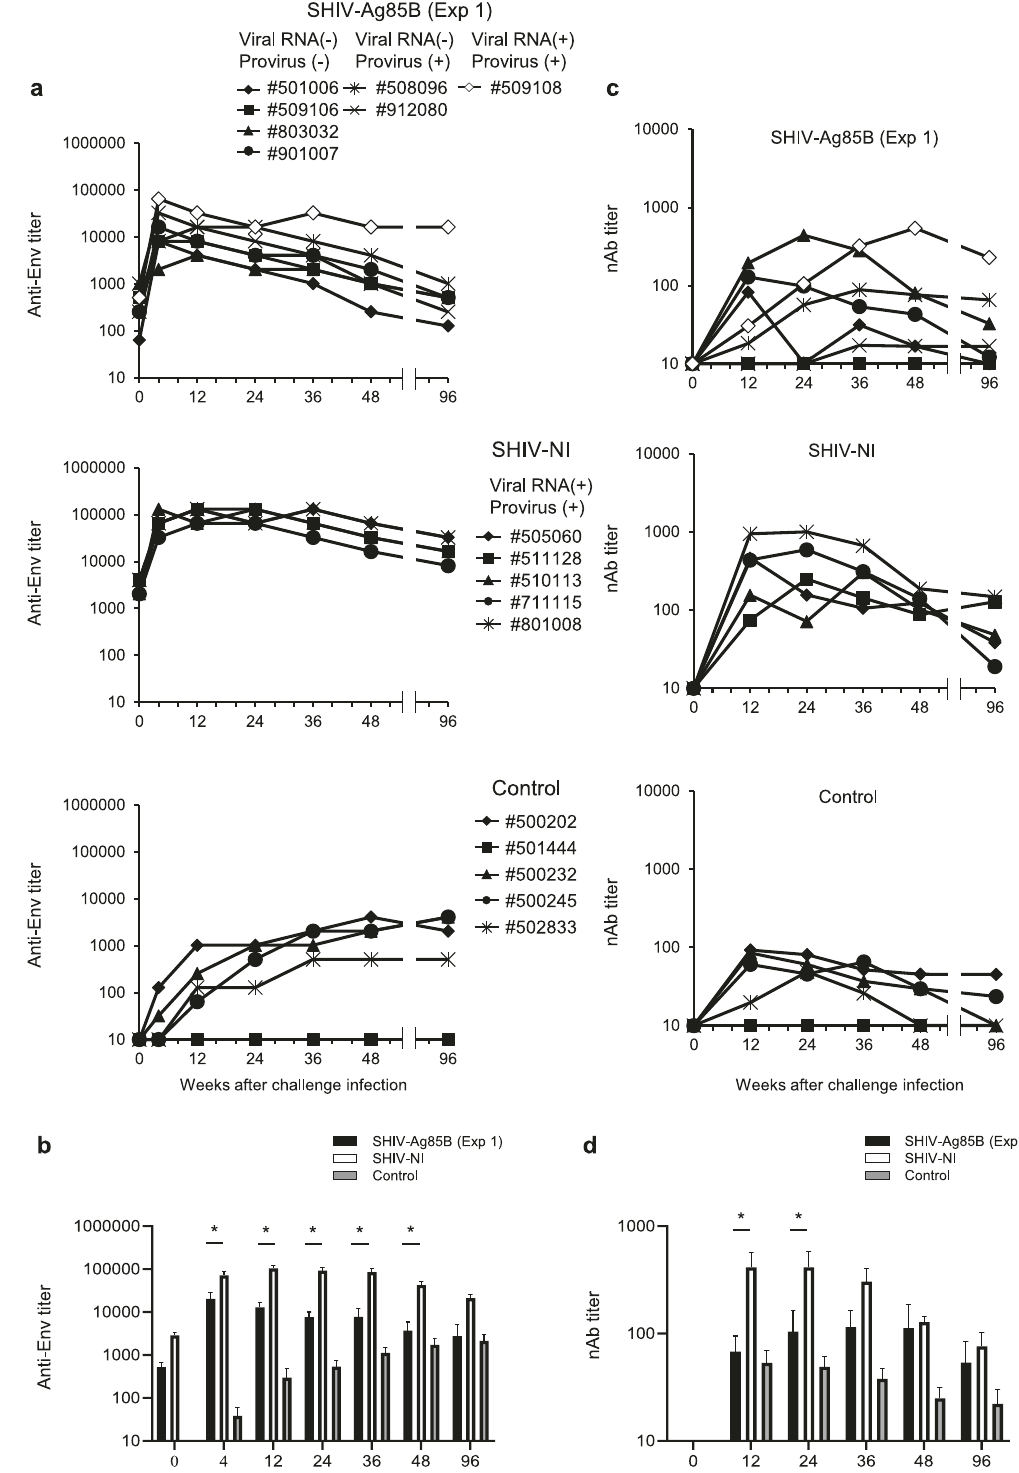
DNA were detected in two macaques (#508096 and